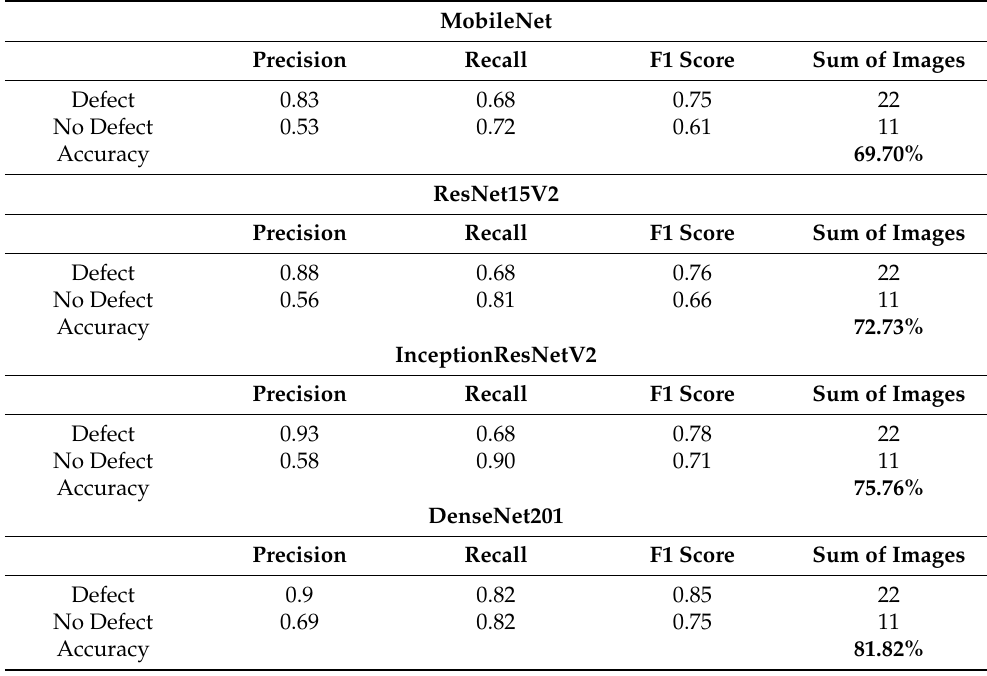
Table 7. Combined classification reports for defect recognition classifiers.